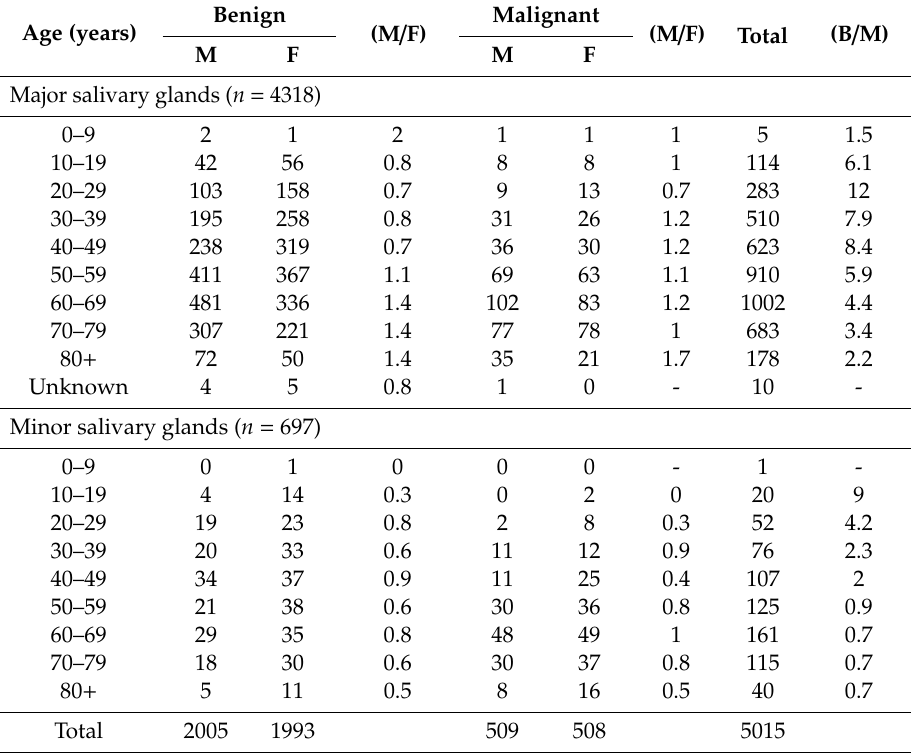
Table 1. Age and sex distribution in 5015 salivary gland